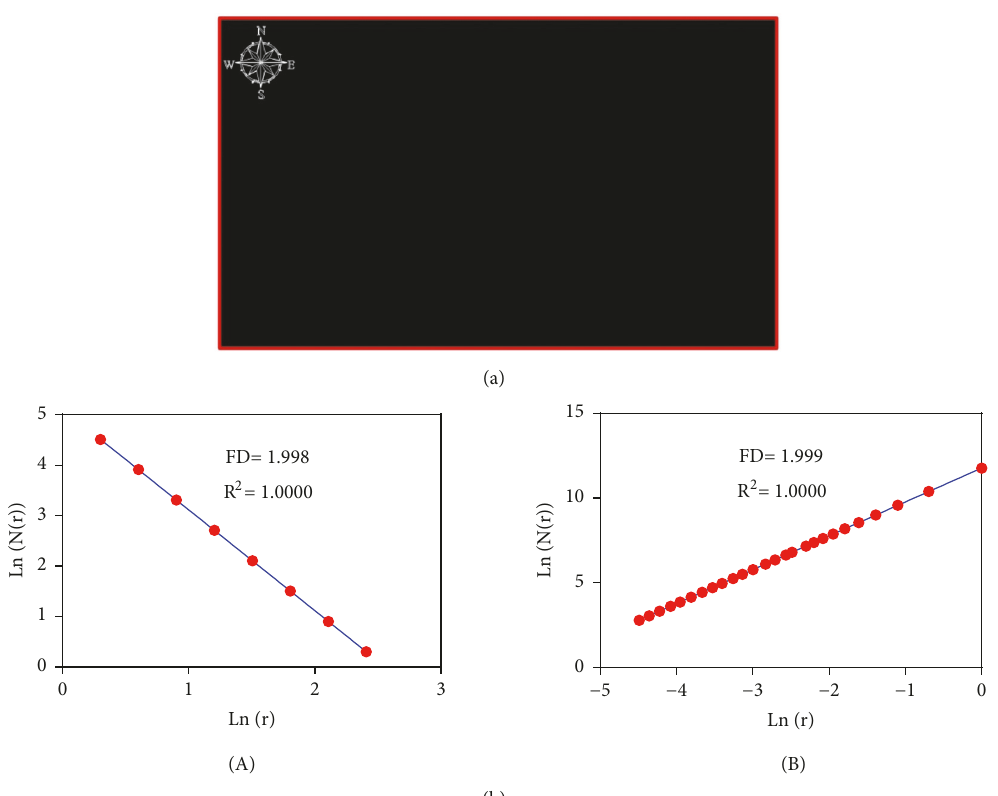
Figure 8: (a) 2D image with full filling space (black image). (b) Plot regression of the number of boxes N(r) against box side length (r) on logarithmic scales (A) using fractalyse 2.4 and (B) using HarFA